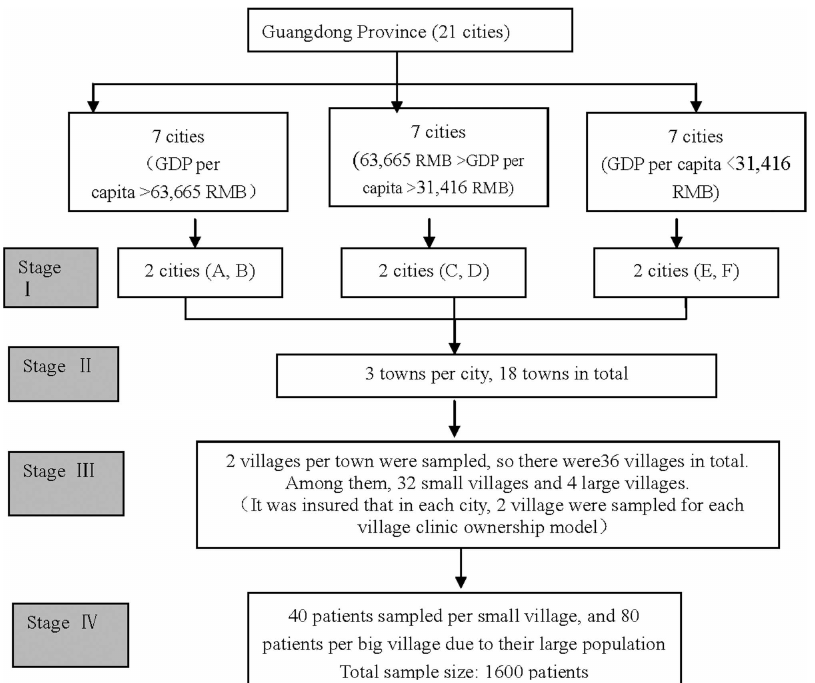
Fig 1. The Flow Chart of Sampling. Three inclusioncriteria were established in the selectionof study participants: 1. The study participantsshould be aged 18 or older. 2. The study participants must sign the written consent. 3. The study participants must have visited a VC at least once in the past year. The interviewers were postgraduates and undergraduate students from the School of Health Management of Guangzhou Medical University. They were trained on how to conduct the survey in order to improvethe completeness and consistency of the investigation. The interviewers were introducedto the participantsby local acquaintances, and they could be villageheads, women’sdirectors, or the respectedsenior citizens. The data were collectedthrough face-to-face interviews, and the questionnaires were administrated by the investigators at respondents’ home. It took about 20 minutes to finish the survey, and a gift was given to each participant as a token of appreciationfor the